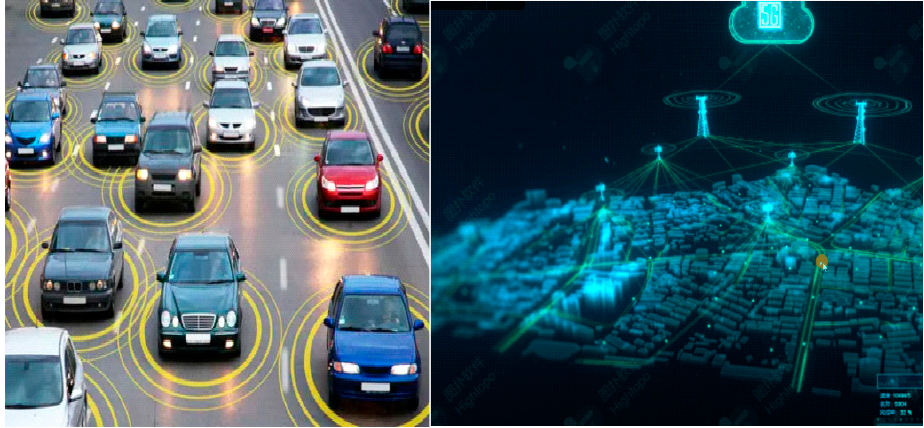
Figure 3. Architecture of the vehicular network system based on digital twins.